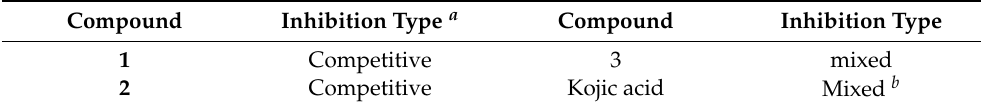
Table 2. Inhibition type of ( Z )-BPT derivatives 1 – 3 and kojic acid.